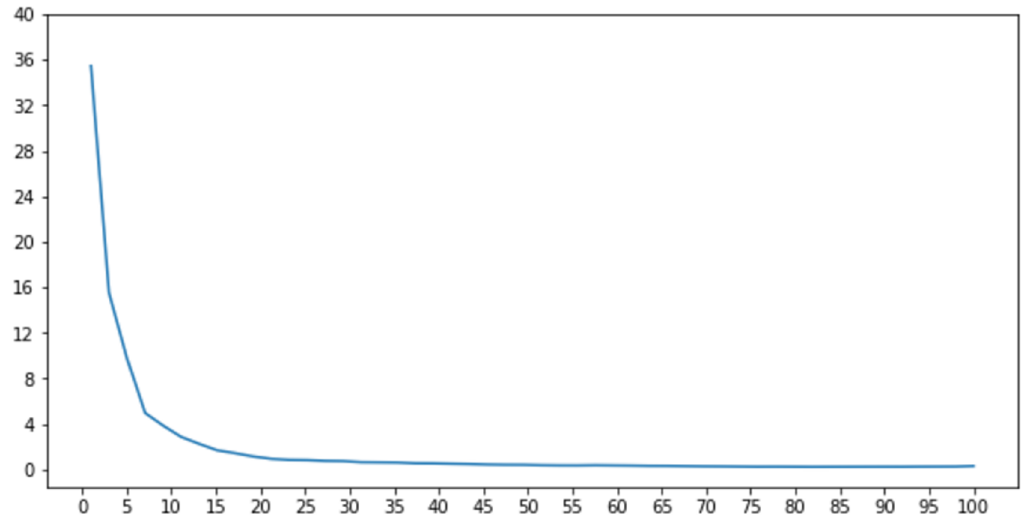
Figure 12 . Skaq percentiles comparison to random baseline for the C 2 ⊗ C 4 decomposition for su (8) . x -axis denotes the percentile q and y -axis the ratio of the percentage of solutions (out of 282) in that percentile over ( q %) 2 . Again, we see that in low percentile 1 − 5 territory, our data exhibits a strong skaq signal by having ∼ 35 − 10 times relatively more entries than the random